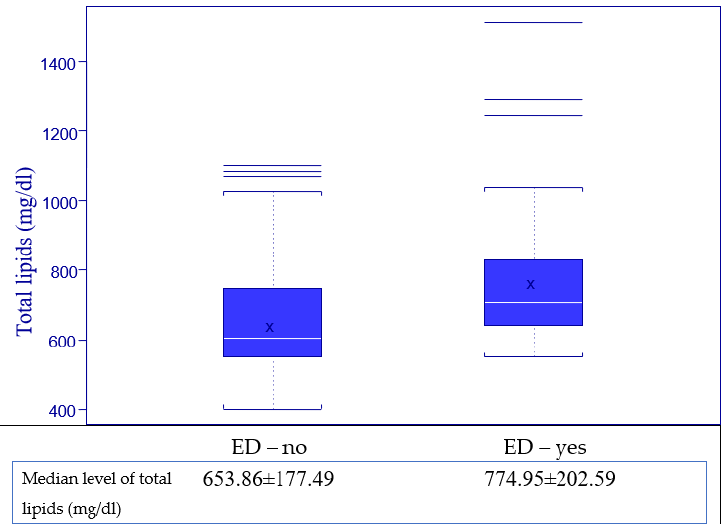
Figure 6. Distribution of total lipids related to erectile function.